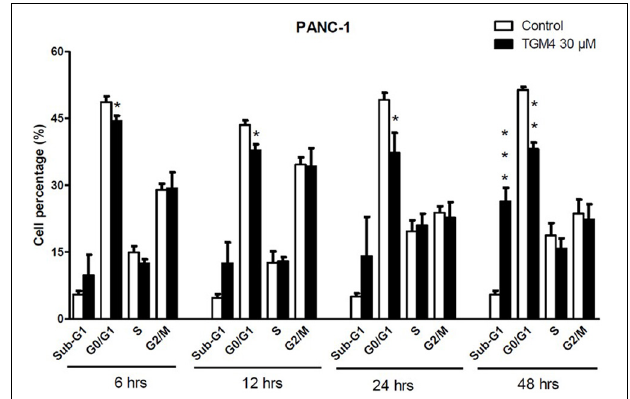
FIGURE 3 | Tri-2-hydroxyarachidonein induction of sub-G1 and cell cycle arrest at G0/G1 of PANC-1 human pancreatic cells. Analysis of the DNA content (flow cytometry) of PANC-1 cells exposed to TGM4 (30 µ M for 6, 12, 24, and 48 h) showing the proportion of cells in the cell cycle phases. Data represented as mean ± SEM ( n = 3). Statistical significance was determined by unpaired two-tailed Student’s t -test (* p < 0.05; ** p < 0.01; *** p < 0.001).